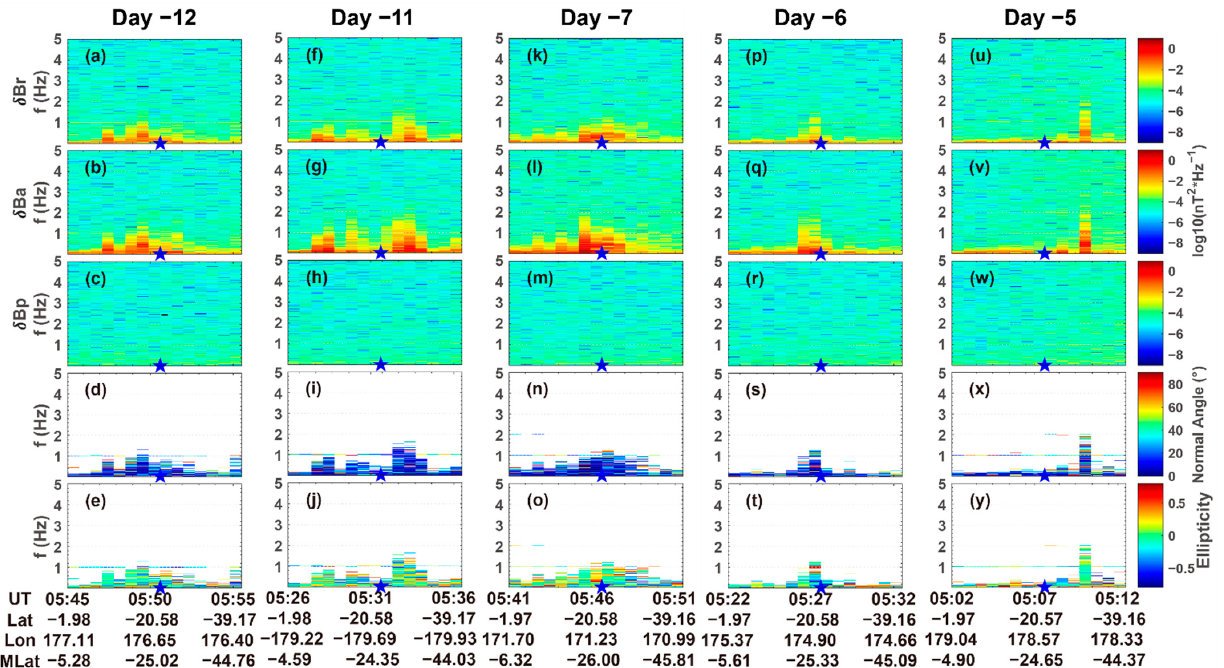
Figure 6. Power spectral density and polarization parameters corresponding to Swarm B orbits in Figure 3. Different columns represent different orbits. For example, the first column shows the power spectral density in panels ( a – c ), as well as the wave normal angle and ellipticity in panels ( d , e ) on day − 12. The second to fifth columns ( f – y ) show the power spectral density and polarization parameters on days − 11, − 7, − 6 and − 5. The blue star indicates the epicenter.